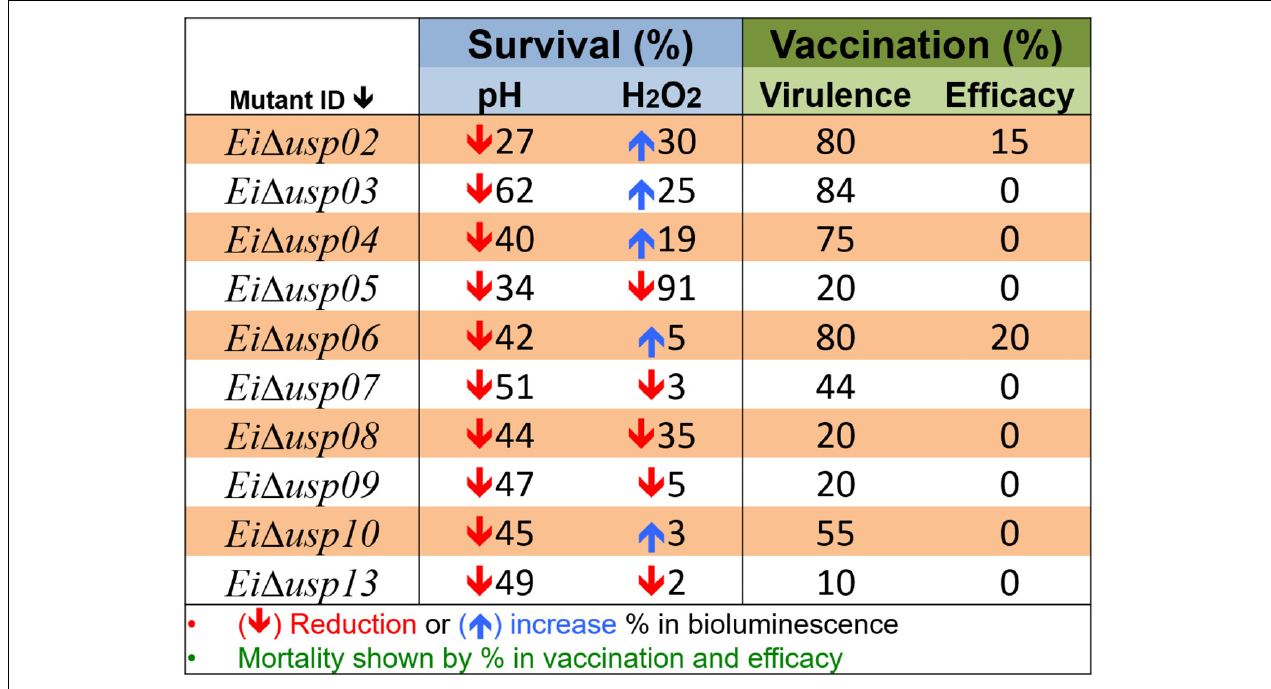
FIGURE 7 | Overall summary of results. Survival percent under acidic (pH) and oxidative stress (H 2 O 2 ) conditions was calculated based on changes in bioluminescence signal. The downward direction arrow indicates reduction in survival percent between mutant strain compared with wild type. The upward direction indicates increase in survival percent. Virulence percent is based on catfish mortality after immersion challenge with USP mutant strains. Efficacy perecent is based of mortality after re-challenge the immunized fish with E. ictaluri WT at 21 day post-immunization.